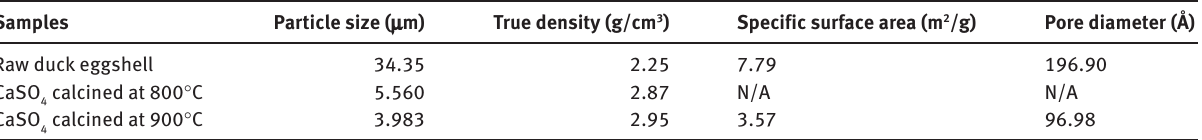
Table 2: Physical properties of